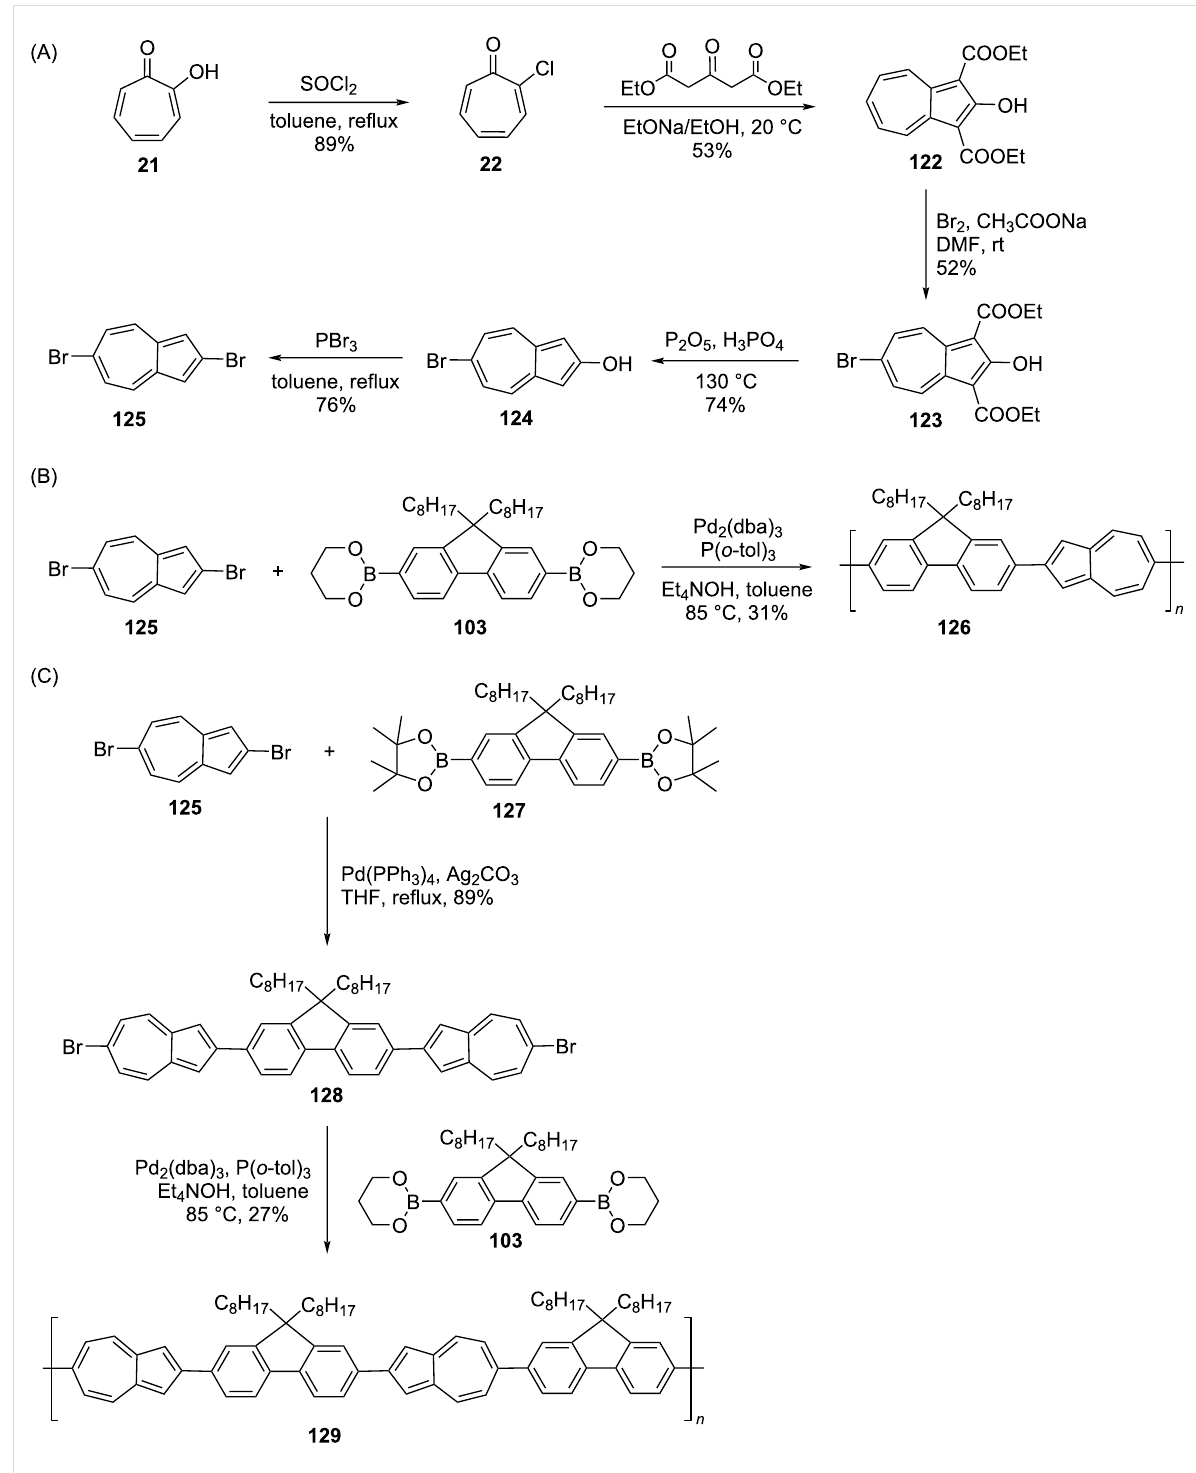
Scheme 21: Synthesis of (A) 2,6-dibromoazulene ( 125 ), (B) azulene-fluorene copolymer 126 , and (C) azulene-fluorene copolymer 129 .